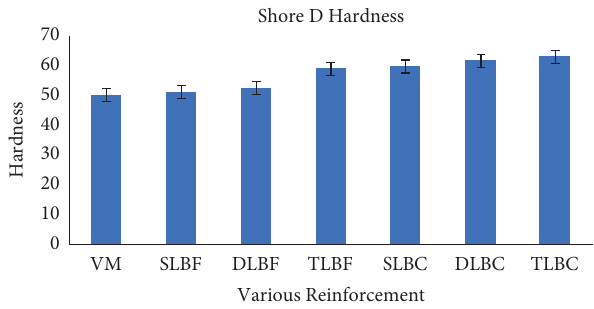
Figure 15: Comparative study of shore D hardness (with standard deviation) with diferent layers of silk fbre and silk cloth and the virgin material.